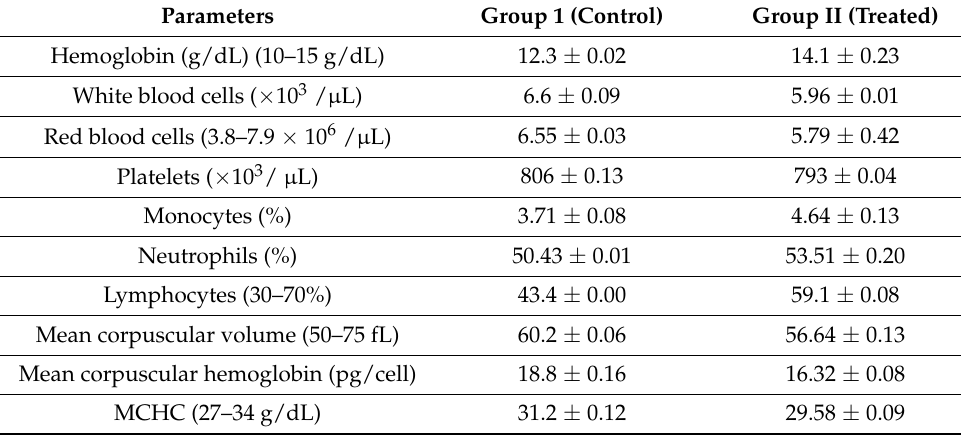
Table 5. Hematological examination of the blood of